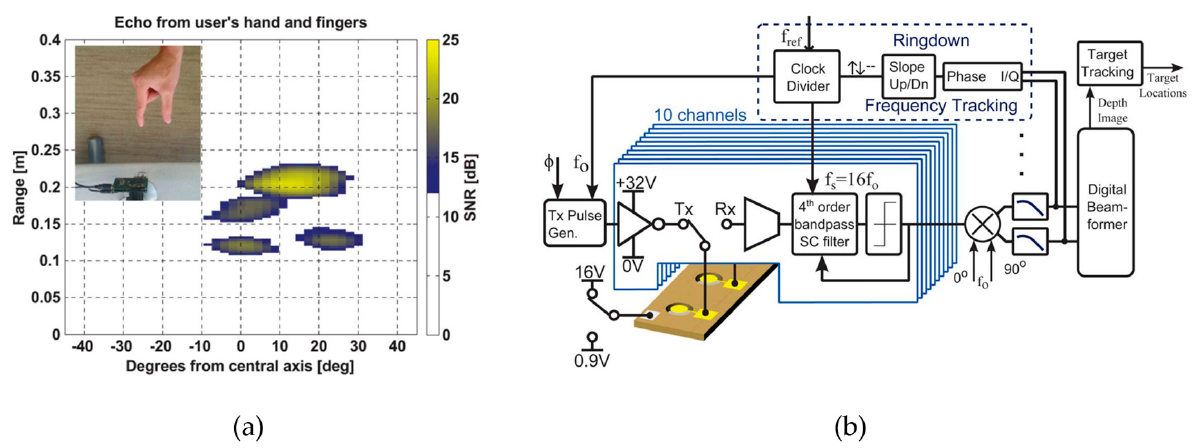
Figure 21. ( a ) A pMUT rangefinder object detection system for gesture recognition. ( b ) Block diagram of the pMUT rangefinder gesture recognition system. Reproduced with permission from [13], Copyright 2015,